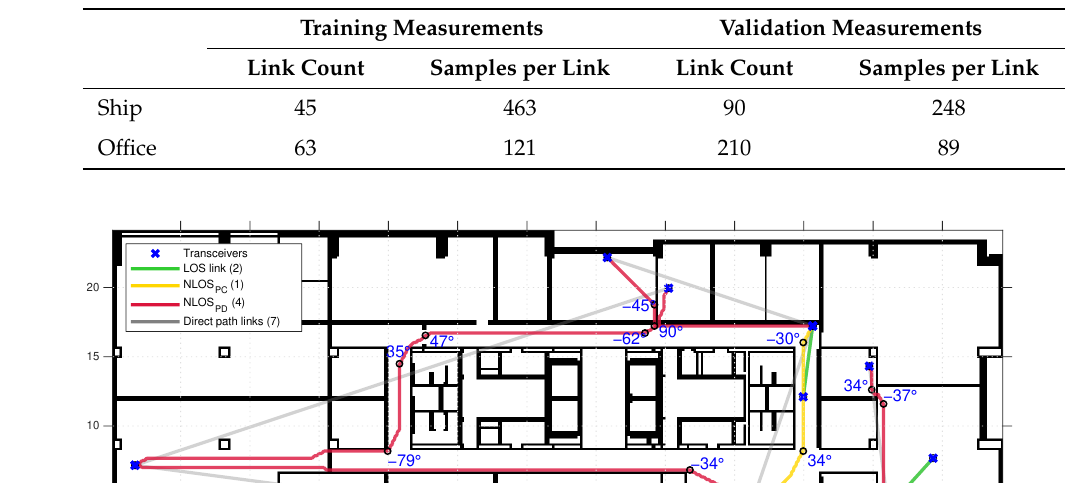
Table 1. Collected number of PL samples per link per measurements environment. A split is made between distinct links used for training and evaluation.